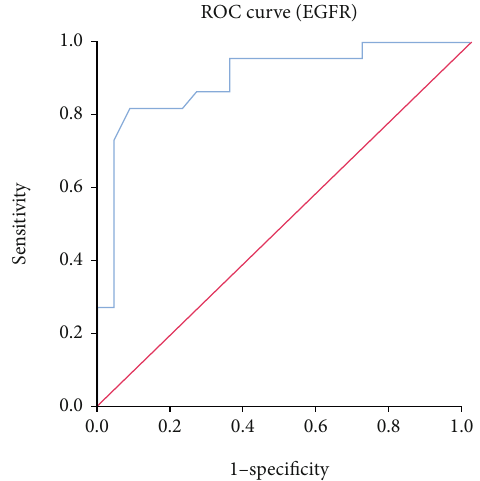
Figure 2: Evaluation of EGFR by ROC curve to determine their sensitivity and speci fi